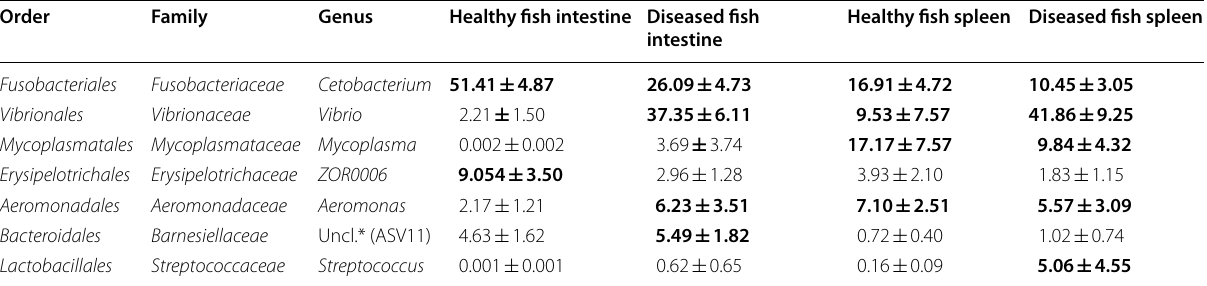
Table 2 Mean relative abundance (percentage SE) of the most abundant genera (with at least 5% mean relative abundance in at ± least one of the fish groups) of the intestinal and spleen microbiota in the studied fish